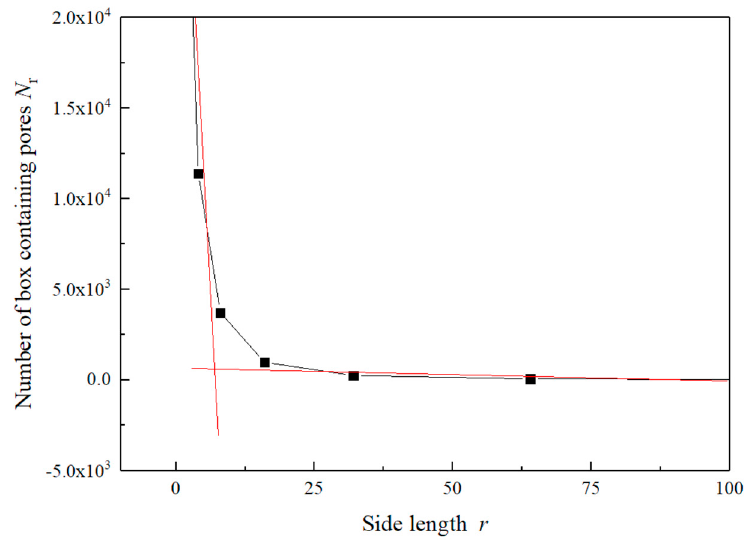
Figure 12. Distribution of the side length against the number of boxes containing pores.